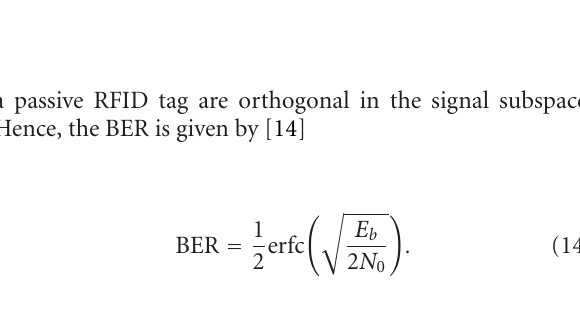
a passive RFID tag are orthogonal in the signal